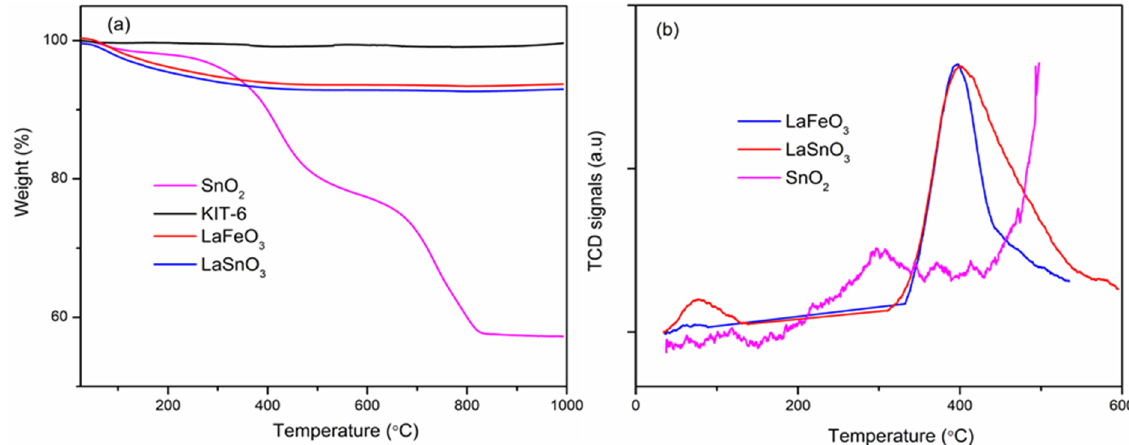
Figure 4. ( a ) Thermograms of the synthesized catalyst and the template; ( b ) their corresponding CO 2 -TPD profiles to determine basic sites. The LaSnO 3 thermogram vertically translated by 0.26%.